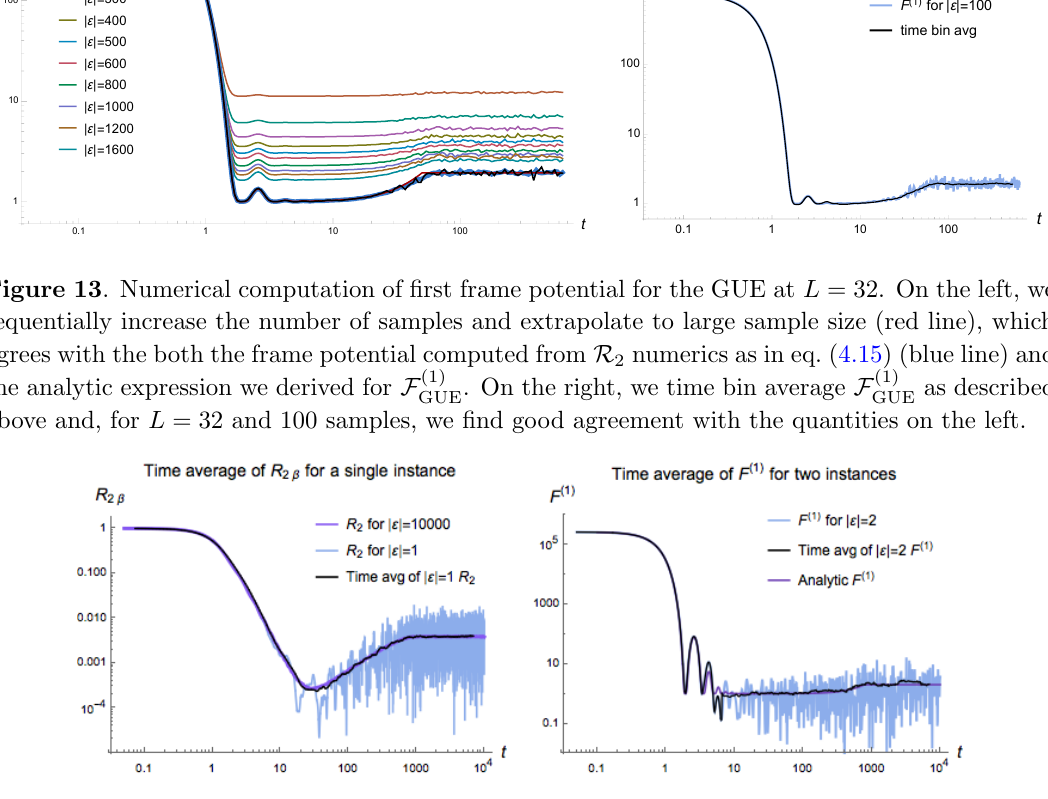
Figure 14 . On the left: the time average of the thermal 2-point form factor at (cid:12) = 5 and L = 500. On the right: the time average of the (cid:12)rst frame potential for L = 500 computed for two instances. In both (cid:12)gures, the time average of the minimal number of instances agrees with the ensemble